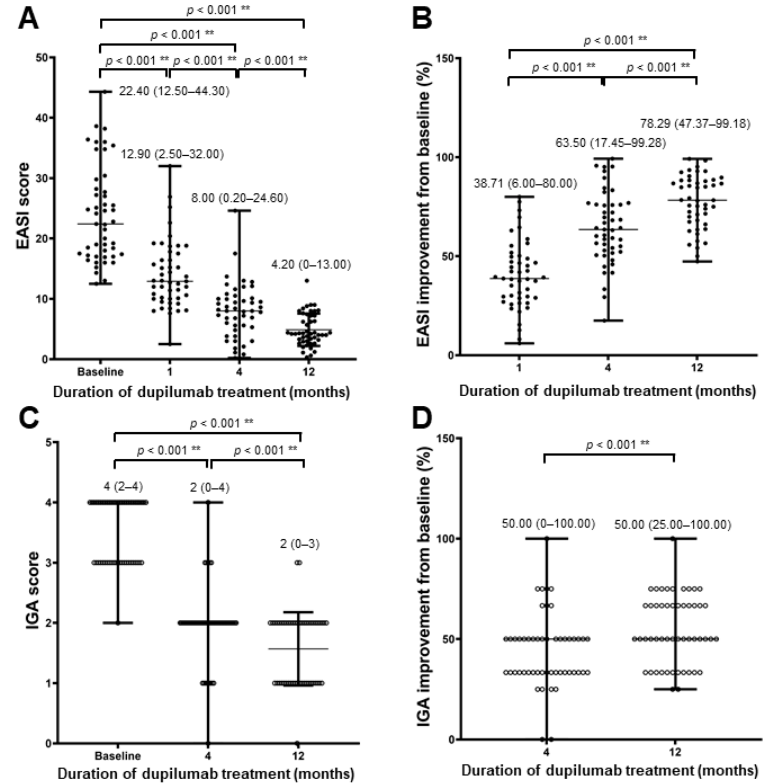
Table 2. Effectiveness of dupilumab in daily practice.